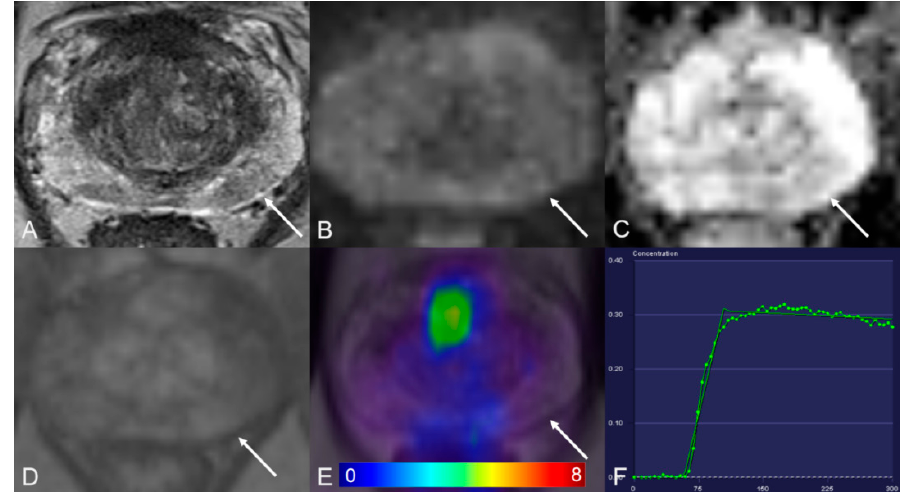
Figure 3. Peripheral zone with a PI-RADS 3 lesion. ( A ) Axial T2WI shows hypointense. ( B ) DWI (b = 1000 s/mm 2 ) shows a mild hyperintense signal. ( C ) ADC map image presents a moderate hypointense signal below the background. ( D ) Early dynamic contrast-enhanced image presents no early enhancement within the lesion. ( E ) [ 68 Ga]Ga-PSMA-11 PET/MRI fusion image shows no positive [ 68 Ga]Ga-PSMA-11 uptake. ( F ) DCE-MRI time-intensity curve demonstrates plateau enhancement. AT: 0.98 min; TTP: 0.67 min; W-in: 0.26; W-out: 0.003; PEI: 0.20; iAUC: 0.13.